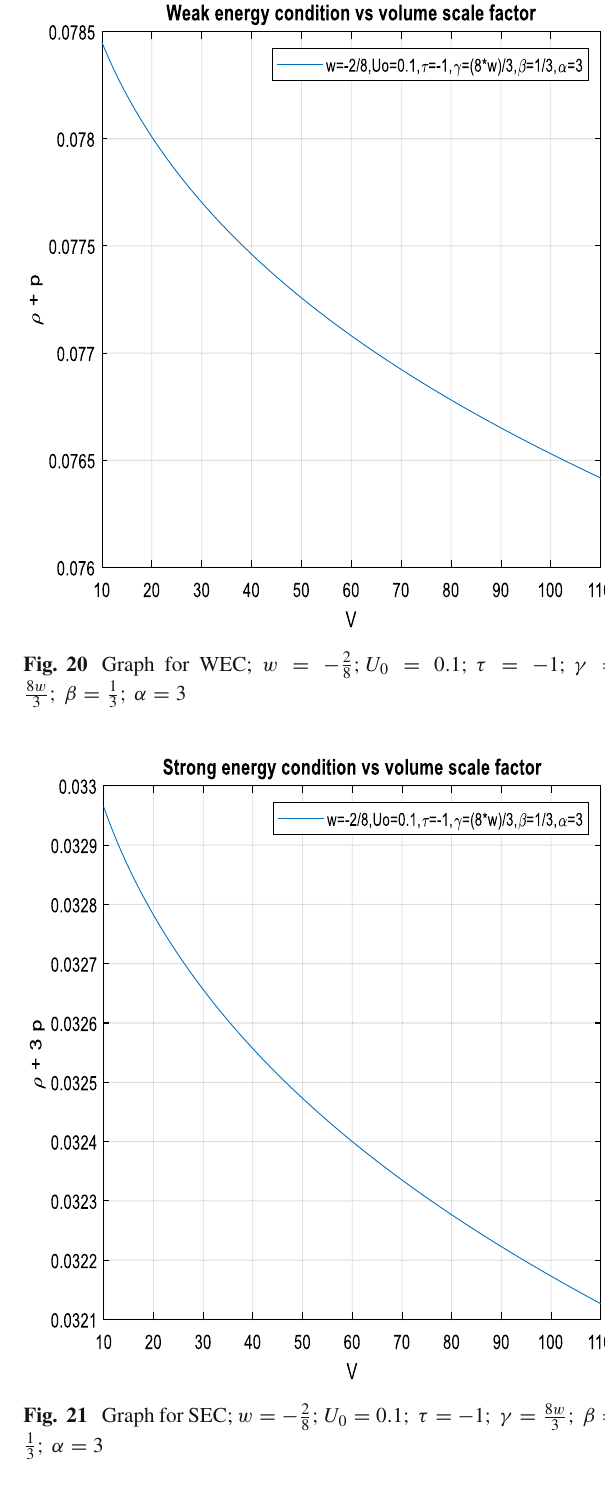
Fig. 21 Graph for SEC; w = − 2 ; α = 1 3